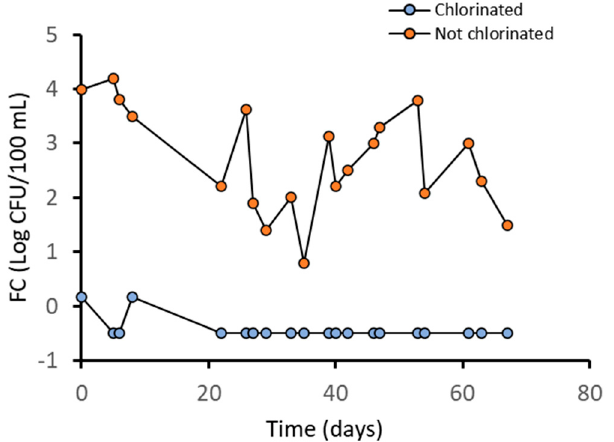
Figure 1. Fecal coliform count of treated, but not disinfected, greywater and after chlorination over time. Values were monitored for a single recirculating vertical flow constructed wetland over >60 days. Treated greywater flow through slow-release trichloroisocyanuric acid (TCCA) chlorine tablets (Kingnod Co. Ltd., Qingdao, China) containing 90% active chlorine. Tablets were placed in an irrigation filter casing, and water flow rate was 100 L/h, with an expected contact time of 36 s of chlorine disinfection.